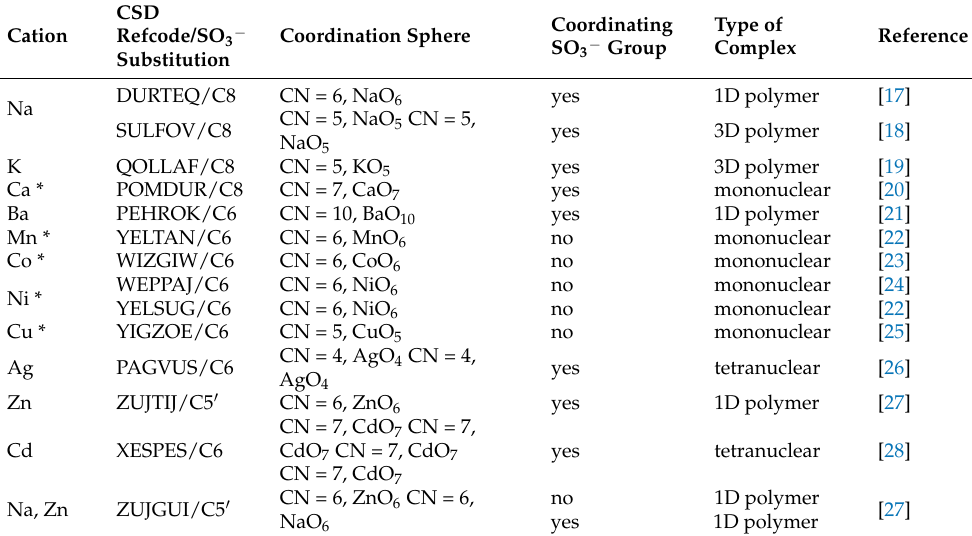
Table 1. The characteristic parameters of complexes of sulfonated flavonoids with metal cations. Refcodes for the crystal structure analyses were taken from the Cambridge Structural